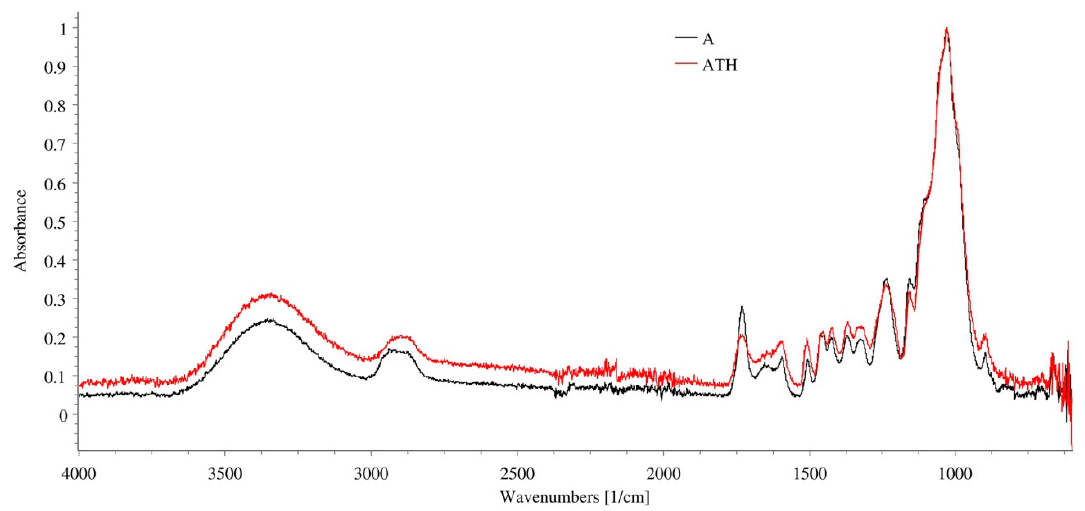
Figure 3. Comparison of FTIR spectra of alder wood (A and ATH, respectively).